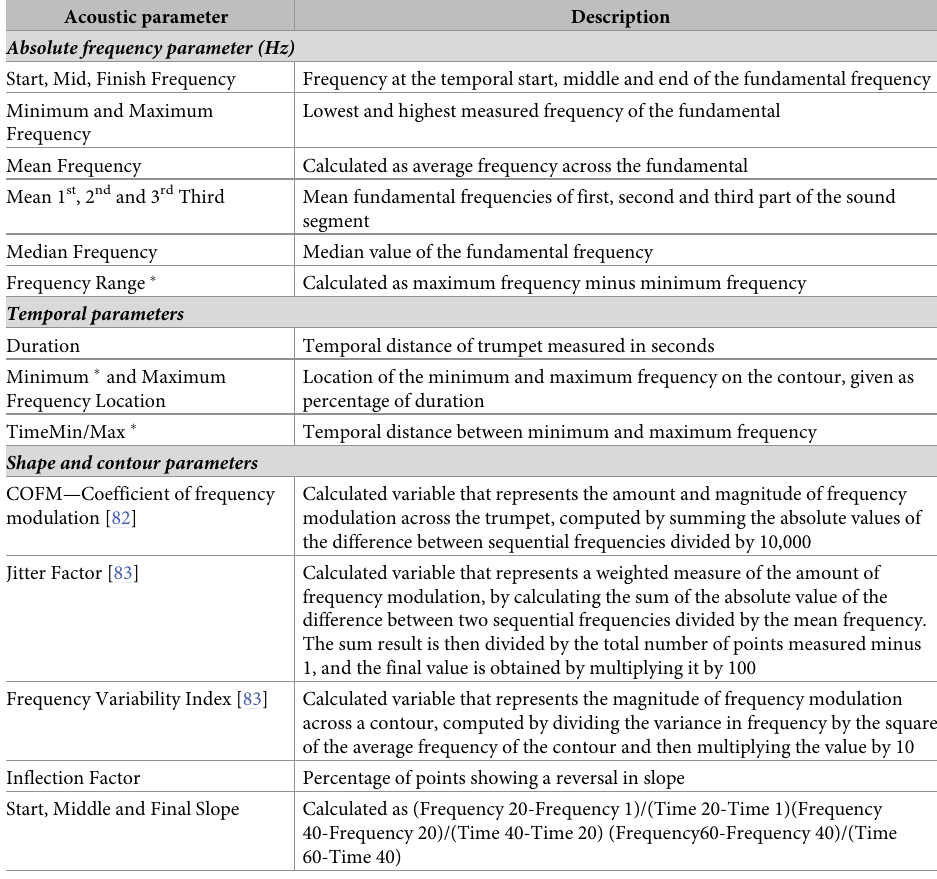
Table 2. Description of the acoustic parameters measured [23,